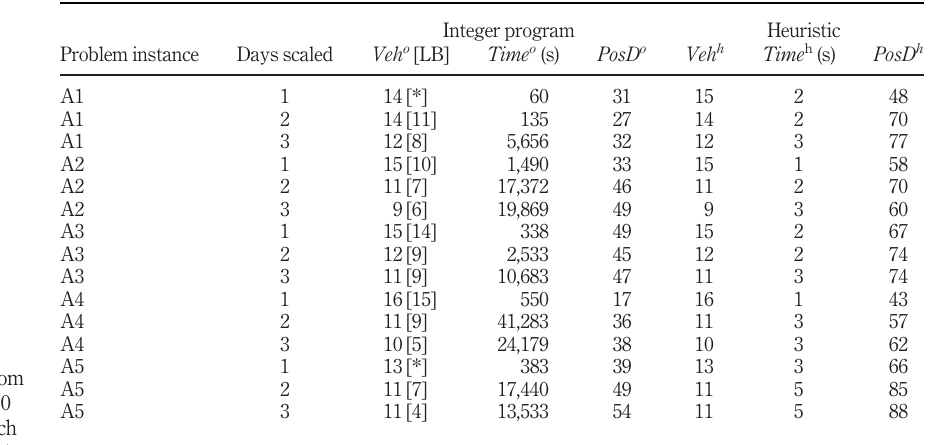
Table 4. Results for random problem set A (10 requirements each problem